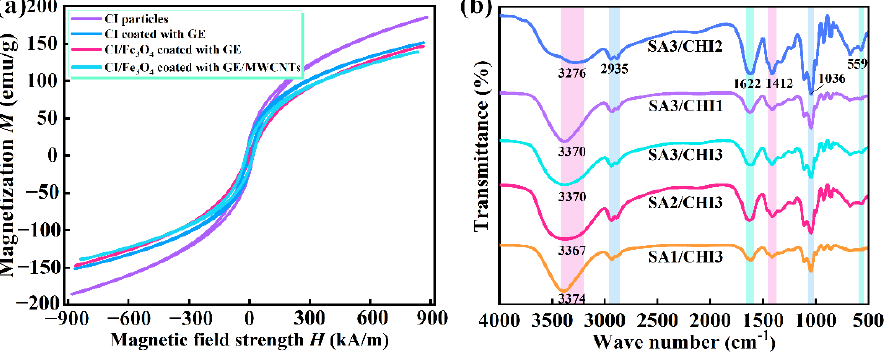
Figure 3. ( a ) Magnetic hysteresis loops of different MPs. ( b ) FTIR spectrum of SA/CHI porous